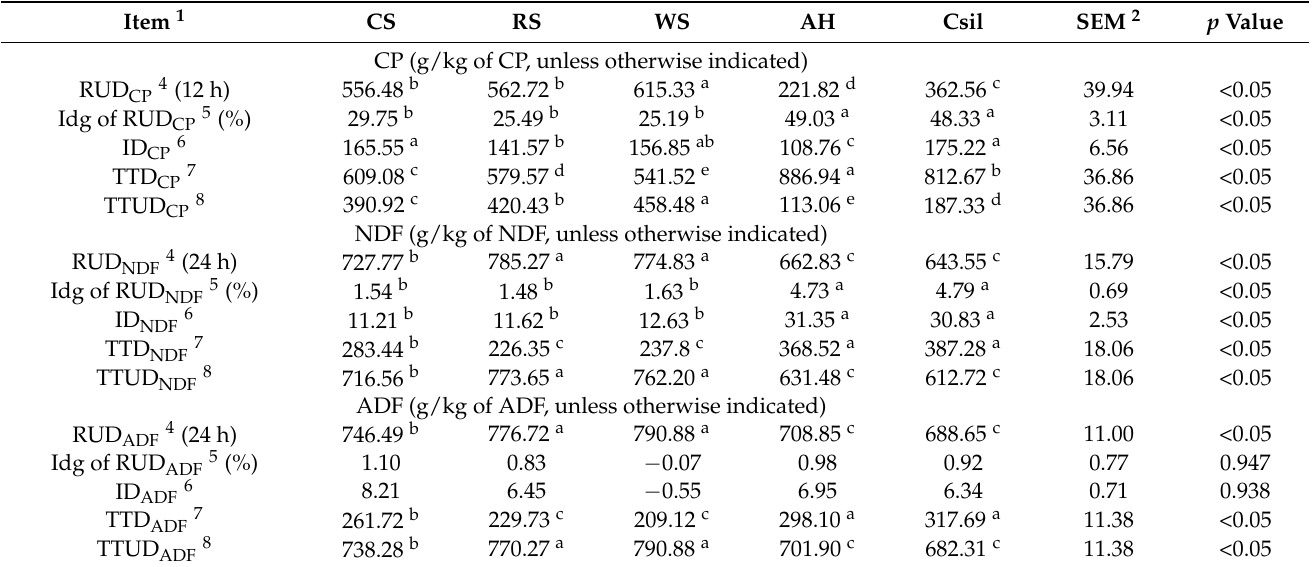
Table 3. Ruminal degradable, intestinal digestible, and total-tract digested content of CP, NDF, and ADF in different forages ( n = 12).